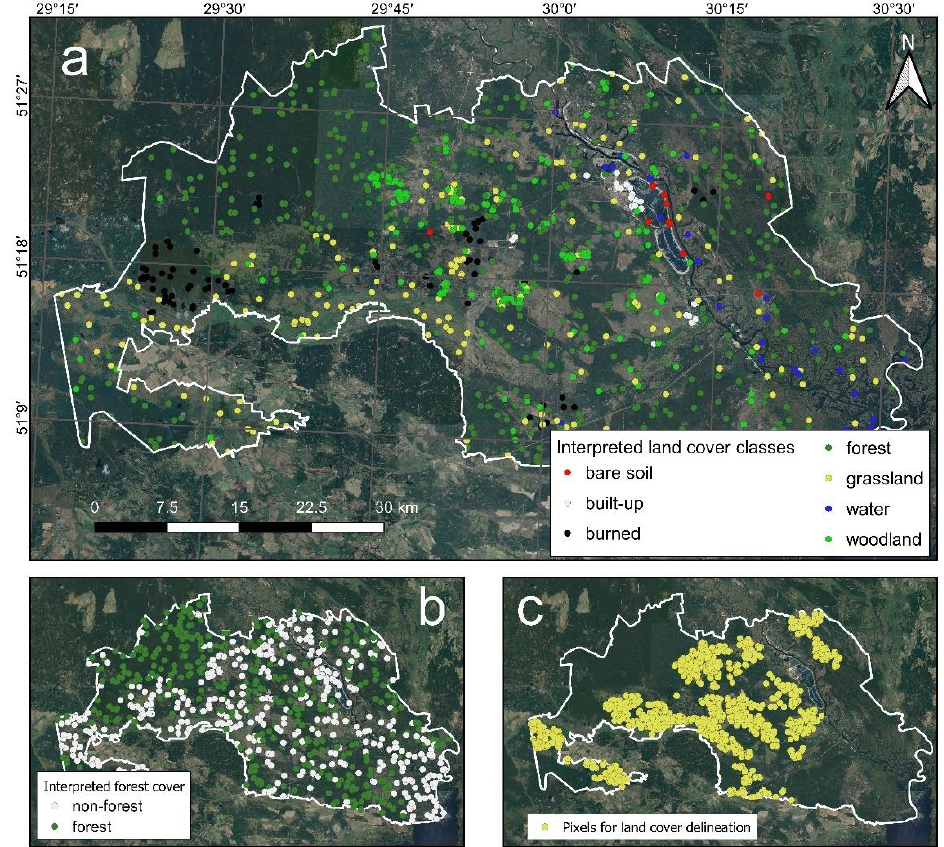
Figure 2. Data sets: ( a ) interpreted land cover training data for the classification model; ( b ) validation data of forest/non-forest cover in 1988; and ( c ) a collection of pixels within abandoned farmlands for examining the land cover transitions.